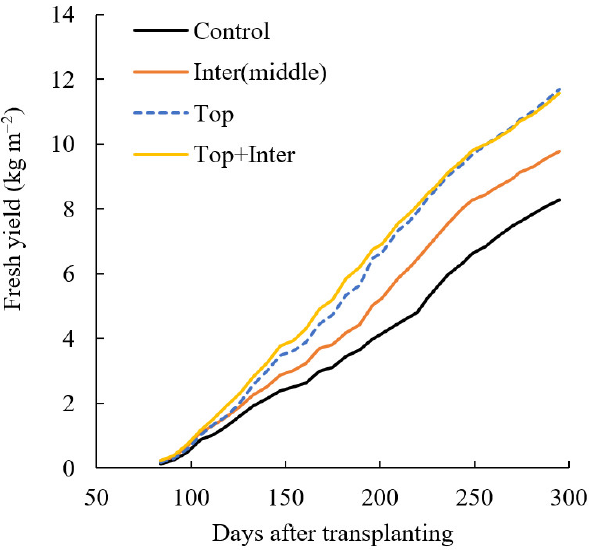
Figure 3. Cumulative fresh fruit yields under control conditions without LED supplemental lighting (SL) and with LED SL. The total daily light integrals were 3894, 4302, 4636, and 5044 in natural light, interlighting, toplighting, and inter- and toplighting, respectively ( n = 10). The cumulative DLI of SL treatments was 408, 742, and 1150 mol m −2 in inter-, top-, and inter + toplighting, respectively. Toplighting LUE was significantly higher than that of inter- + toplighting (Figure 4). Inter- + toplighting LUE decreased by 21% and 38% com- pared with inter- and toplighting, respectively.